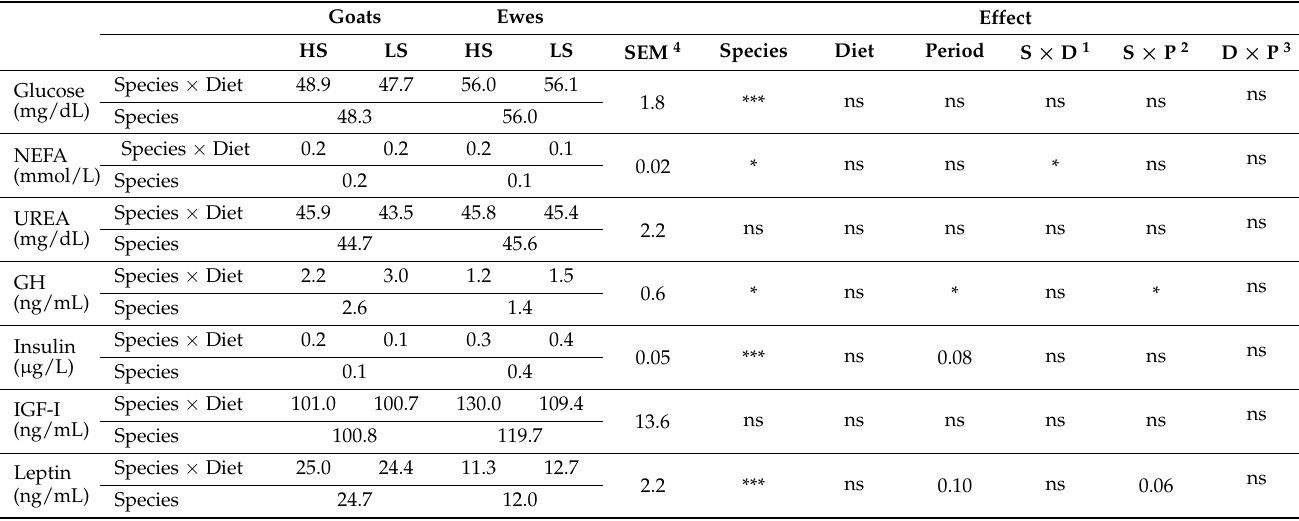
Table 5. Metabolic and hormonal profile (mean ± SEM) in plasma of mid-lactating Saanen goats and Sarda ewes fed high- starch and low-starch diets.